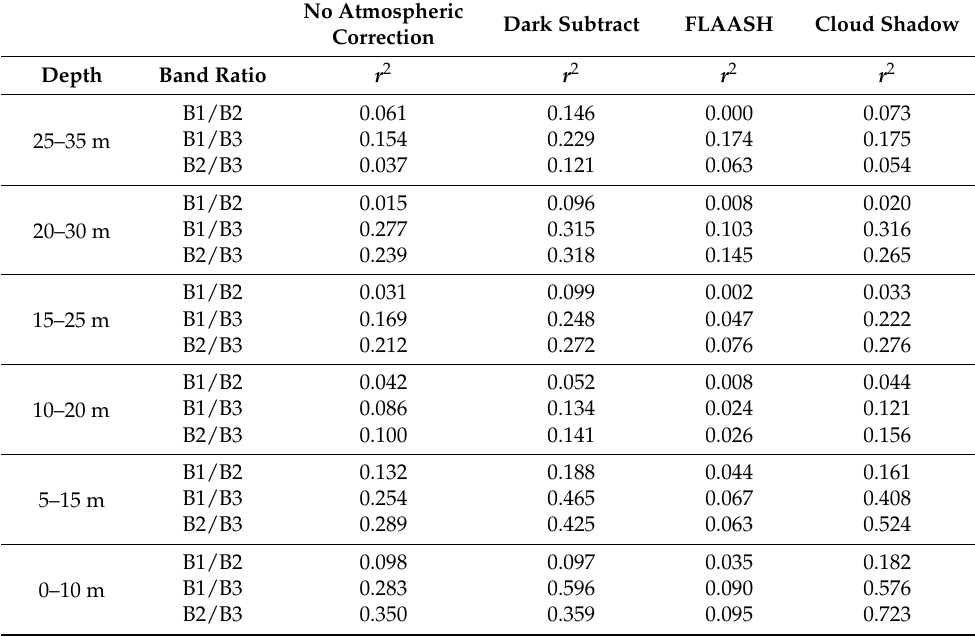
Table 1. The coefficient of determination ( r 2 ) for six depth ranges for the different atmospheric corrections. The performance of each band ratio on (B1/B2, B1/B3, B2/B3) was evaluated when compared with LiDAR bathymetry per pixel values. No Atmospheric Dark Subtract FLAASH Cloud Correction